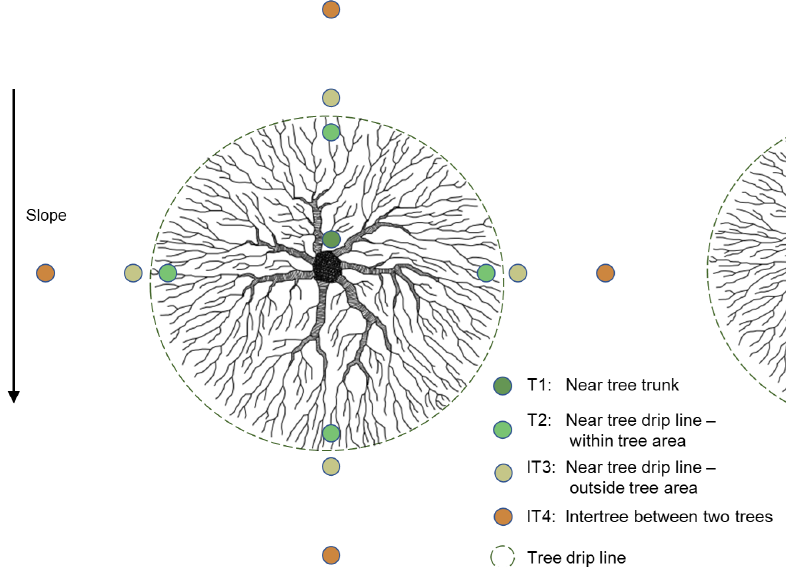
Figure 3. Schematic diagram of soil sampling locations in the tree and intertree area.